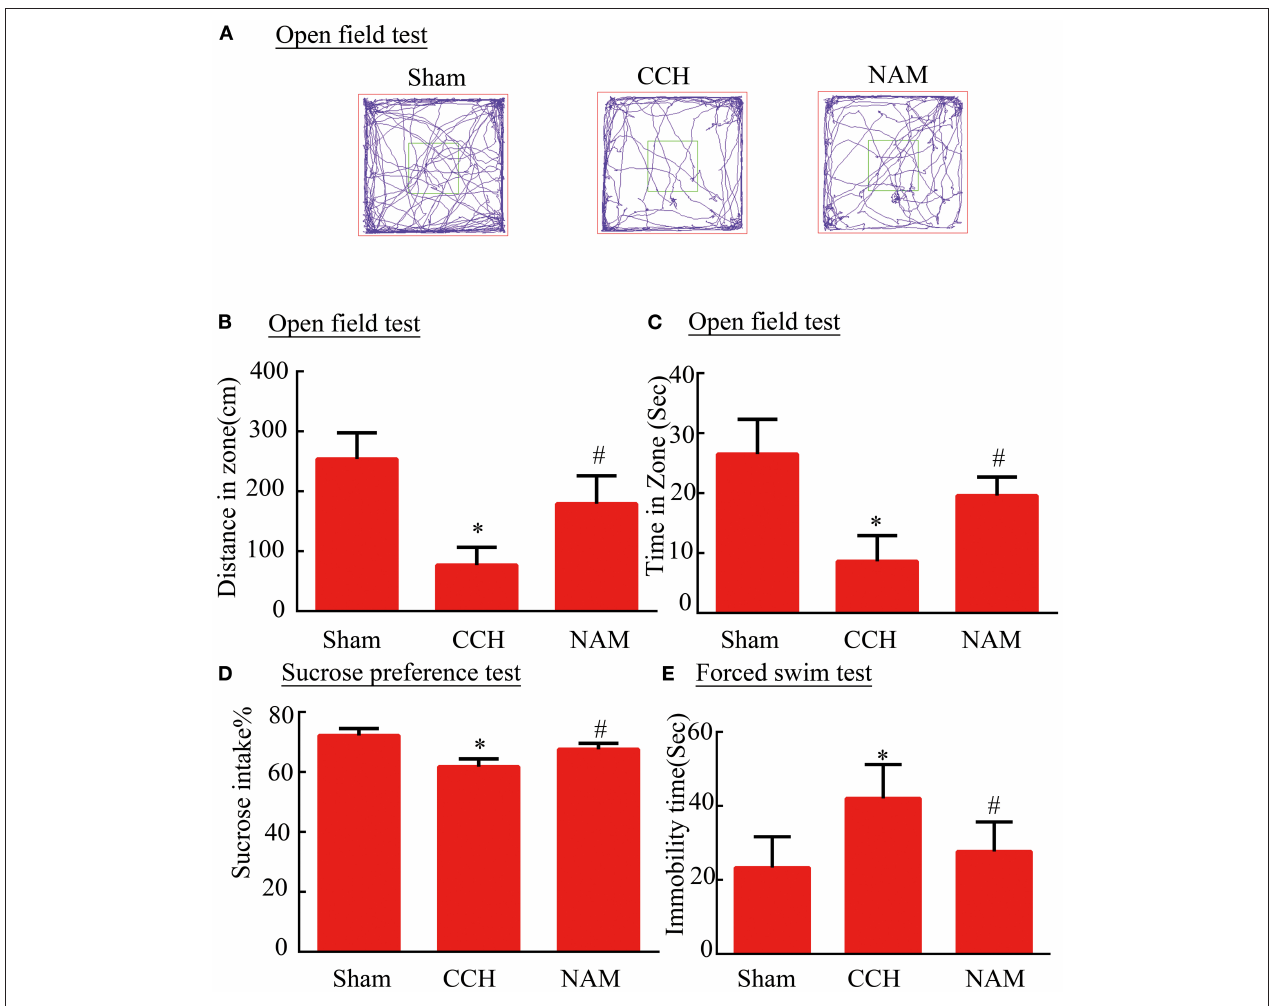
FIGURE 3 | Effect of NAM on behavioral performance ( n = 8/group). (A) : Typical movement tracks, as shown by trace lines in the OFT; (B) : Total distance traveled in the central zone; (C) : Time spent in the central region; (D) : Mice performance in SPT; and (E) : Immobility time of mice in FST. * p < 0.05, compared with sham group; # p < 0.05, compared with CCH